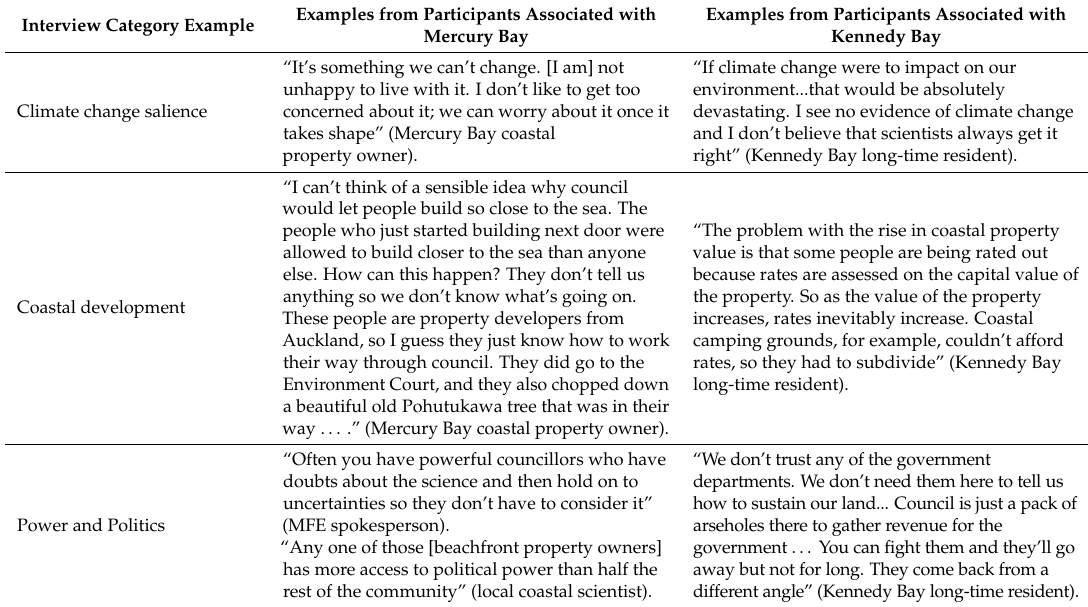
Table 1. Representative examples of research participants’ understanding of coastal risk and development